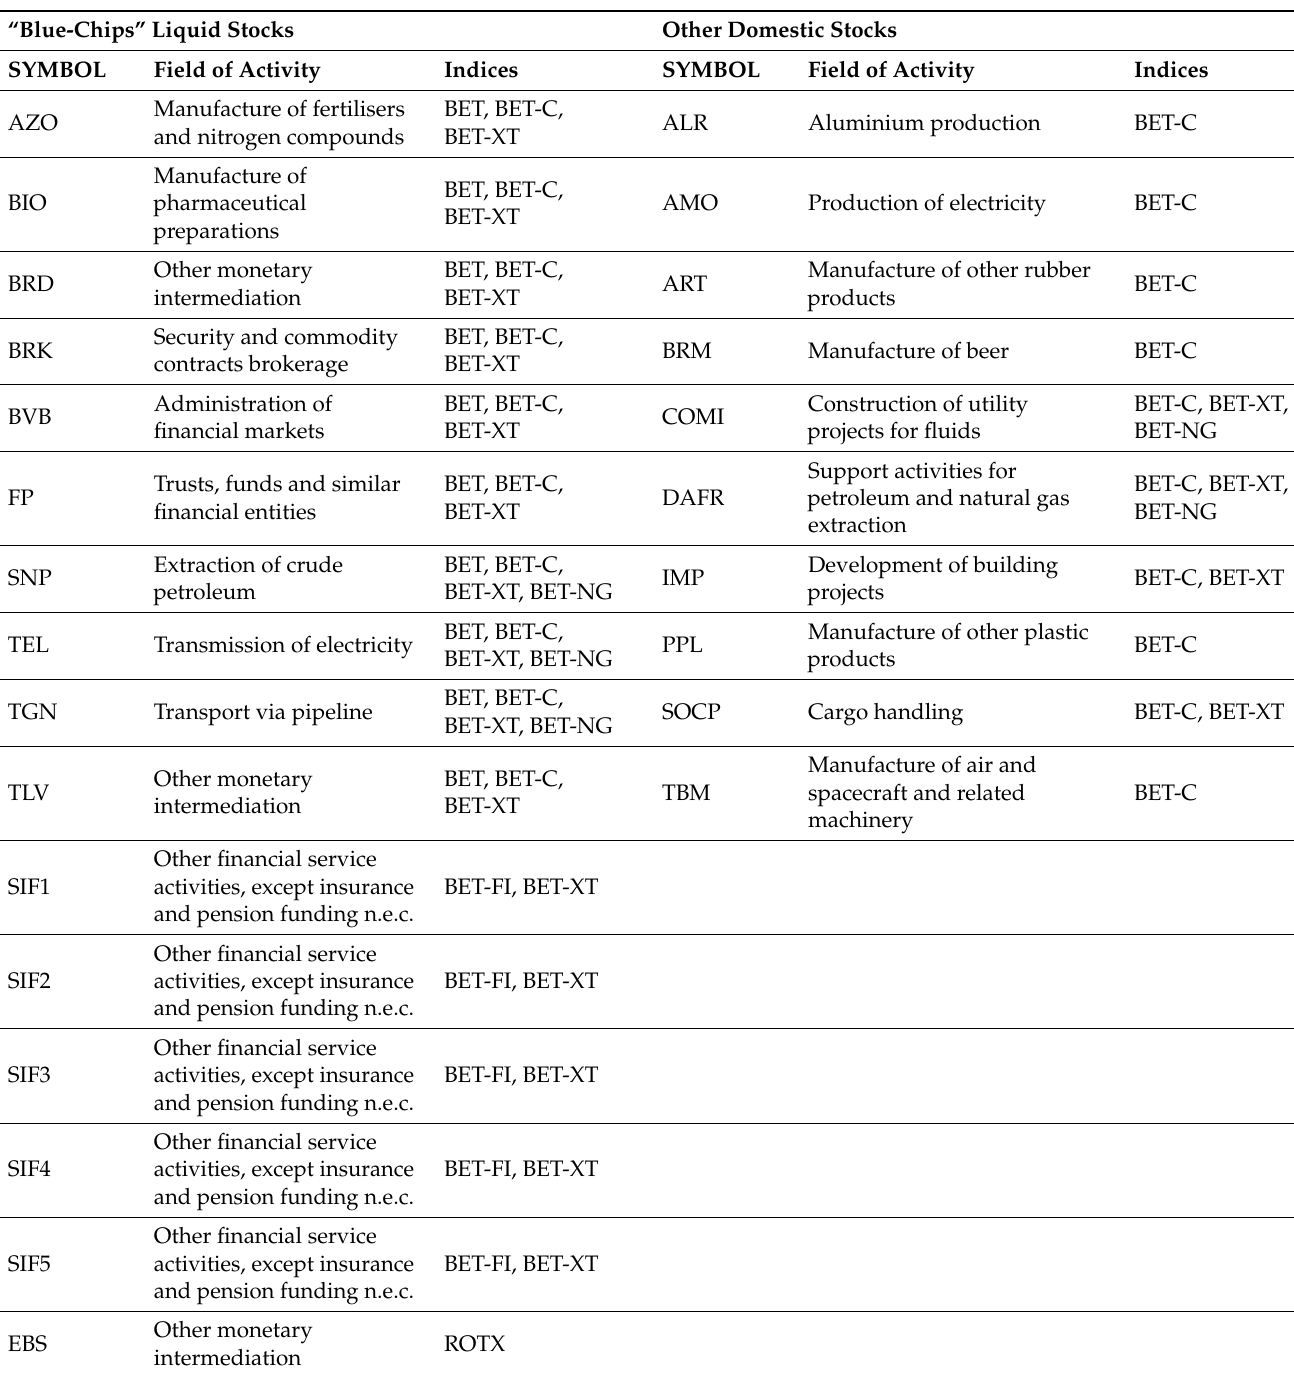
Table 1. List of stocks included in the analysis and their membership to Romanian stock market indices. “Blue-Chips” Liquid